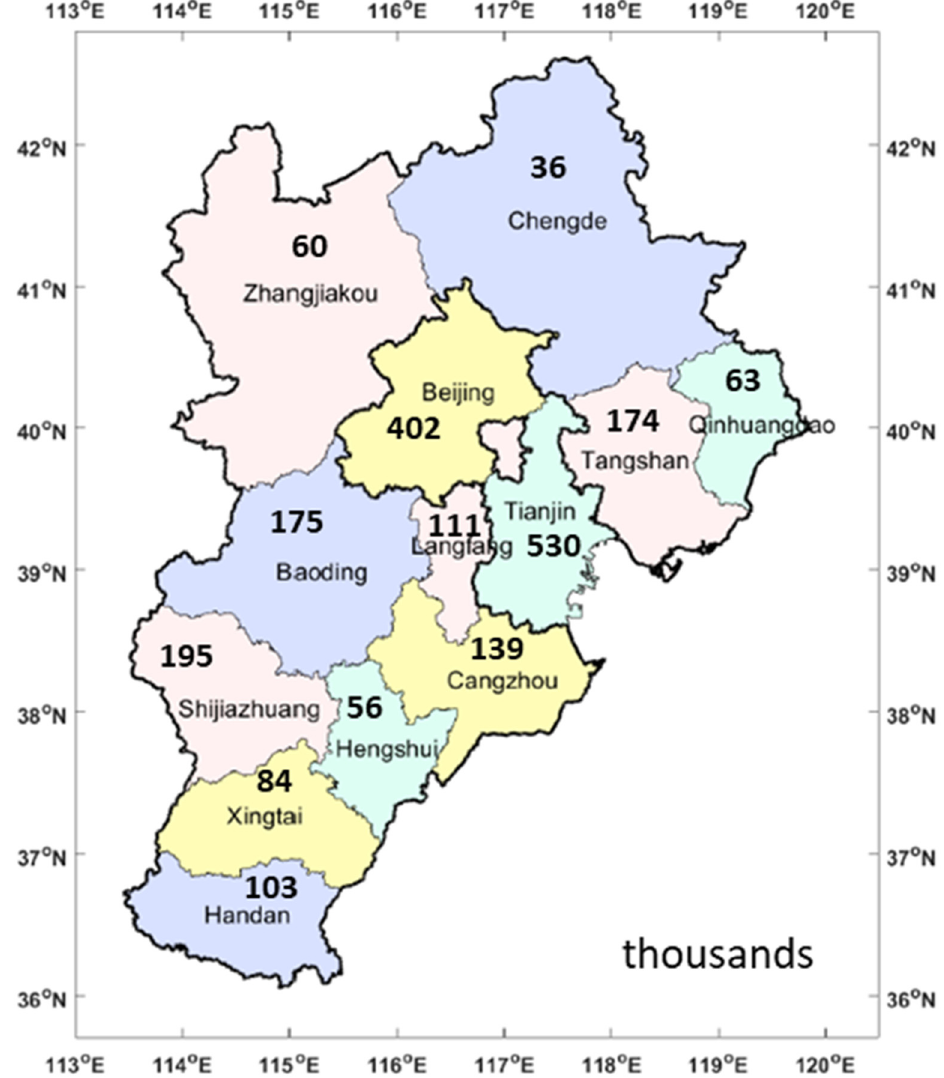
Figure 2. Quantity of restricted HEVs in the BTH region from 2008 to 2015.